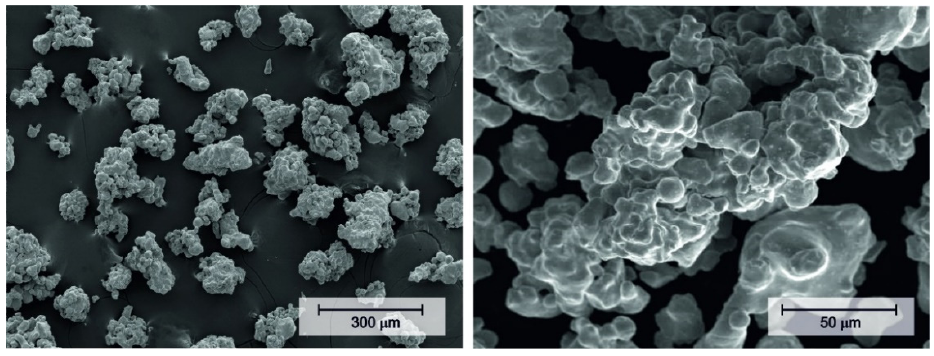
Metals 2018 , 8 , x 4 of 14